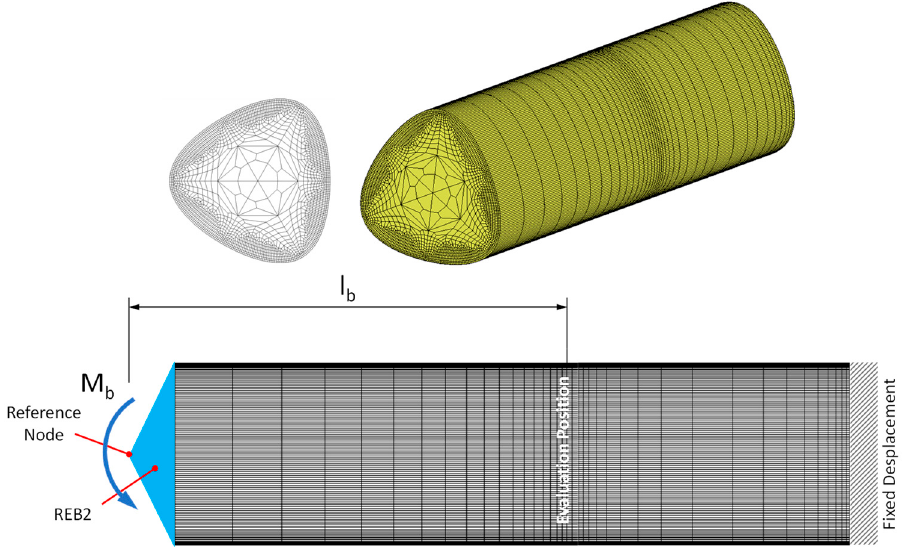
Figure 6. FE mesh and boundary conditions for the H-profile with n = 3 according to DIN 3689-1.